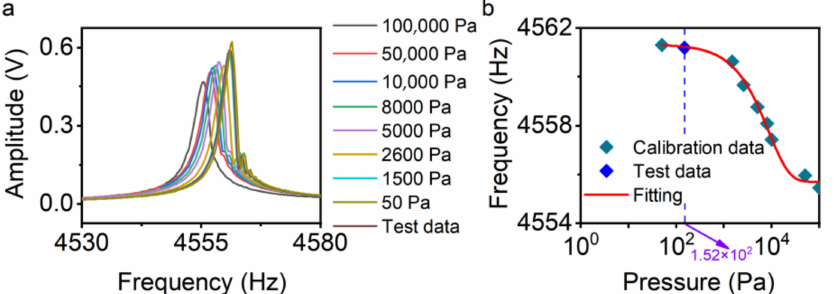
Figure 9. Variation of resonant frequency of cantilever with air pressure of microparticle cham- ber in Chamber I. The test data are obtained through experiments after step (g), and the remain- ing calibration data are obtained through experiments before step (f). ( a ) Resonance spectrum; ( b ) Calibrating